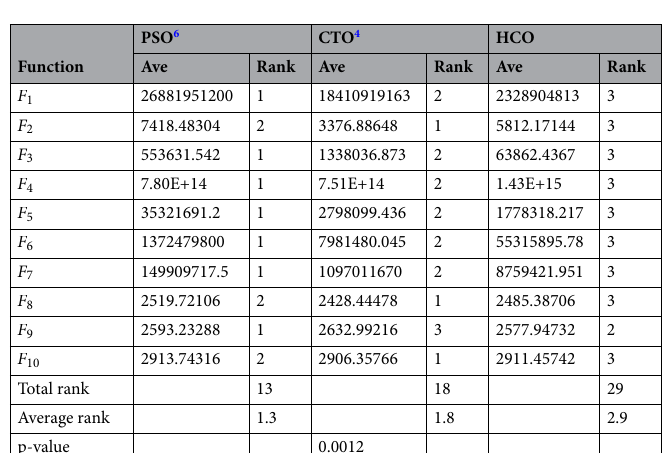
Figure 6. Convergence performance of HCO for 500D CEC2020 benchmark function: ( a ) Convergence graph for F 3 benchmark function. ( b ) Convergence graph for F 6 benchmark function. ( c ) Convergence graph for F 9 benchmark function. ( d ) Convergence graph for F 10 benchmark function.